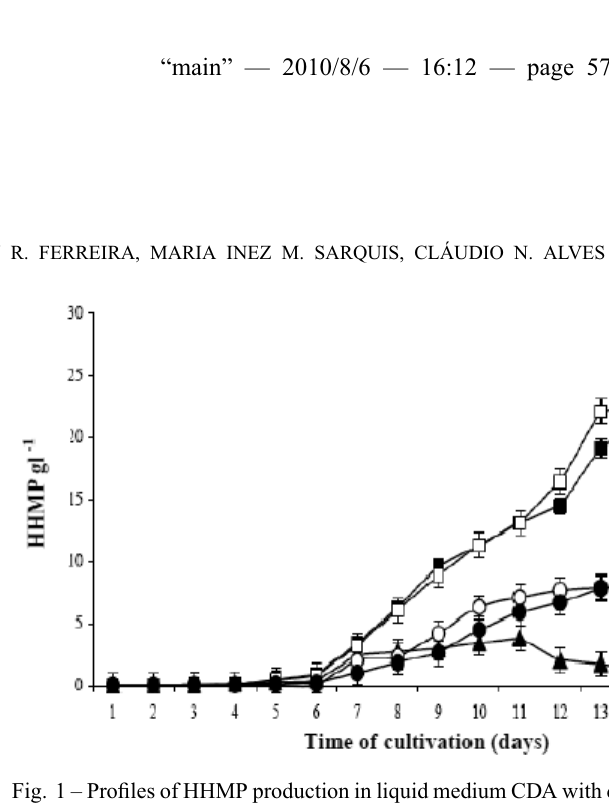
Fig. 1 – Profiles of HHMP production in liquid medium CDA with different sucrose